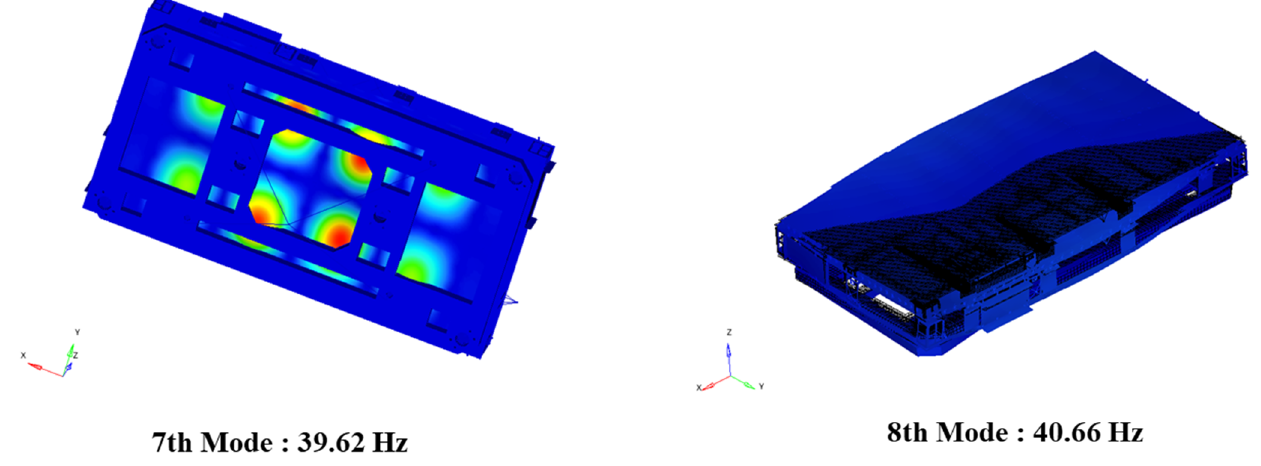
Figure 11. Modal analysis results obtained under the launch